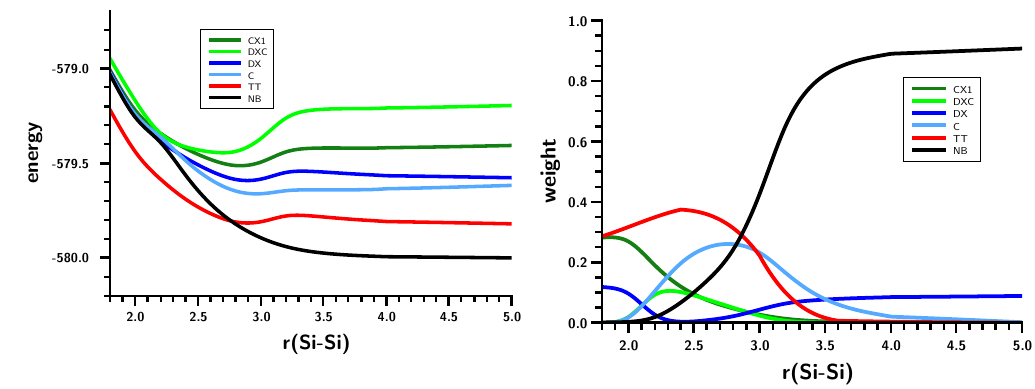
Figure 13. Non-planar silylene dimerization. Energies ( left ) and weights ( right ) of the six most important FO-CSFs. Energy in Hartrees; bond length in Å.